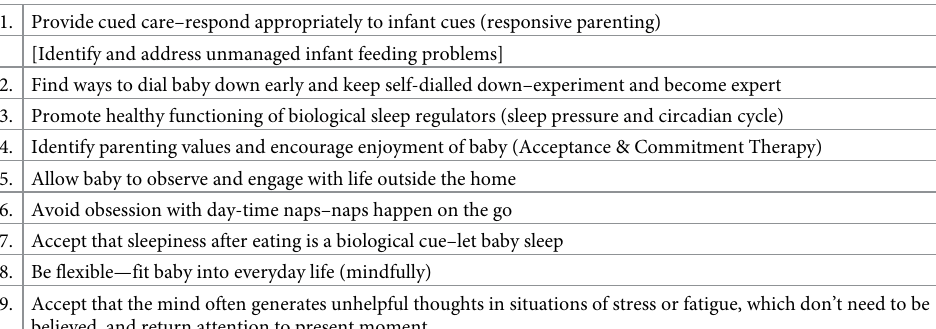
Table 3. Possums Sleep approach key principles.